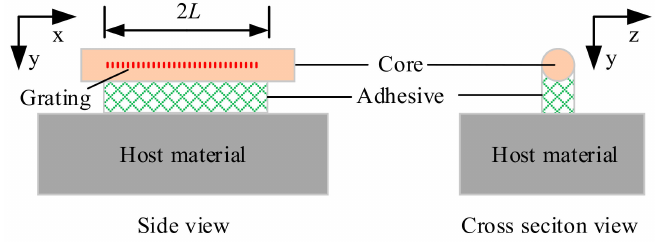
Figure 2. Three-layer model regressed from four-layer model.